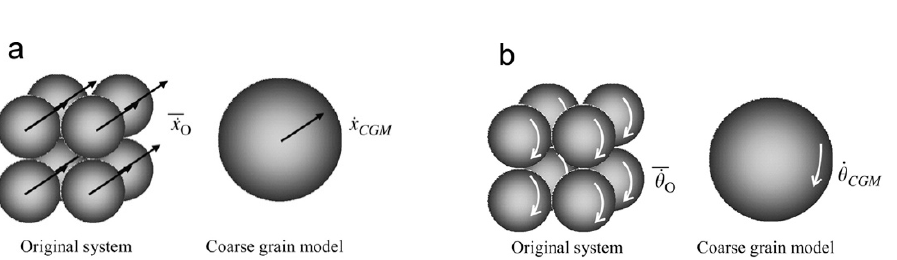
Figure 3. Definition of porous coarse grains in the Energy-Minimization Multi-Scale (EMMS)-DPM model. Reprinted from Reference [16], with permission from Elsevier.